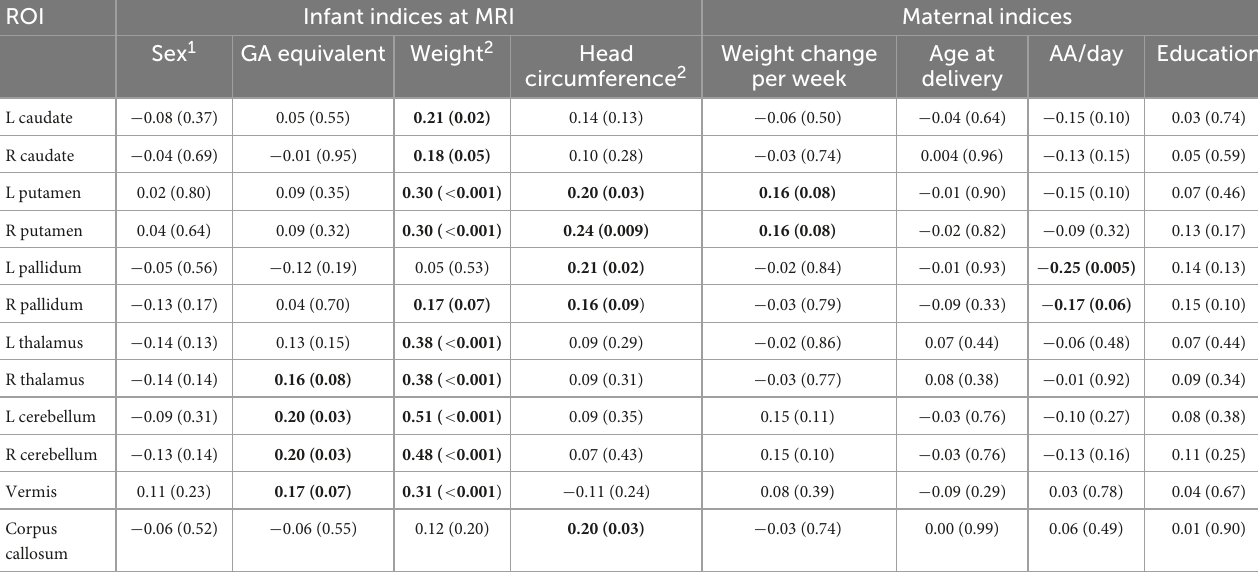
TABLE 2 Associations of regional volumes with potential confounding variables. ROI Infant indices at MRI Maternal indices Sex 1 GA equivalent Weight 2 Head